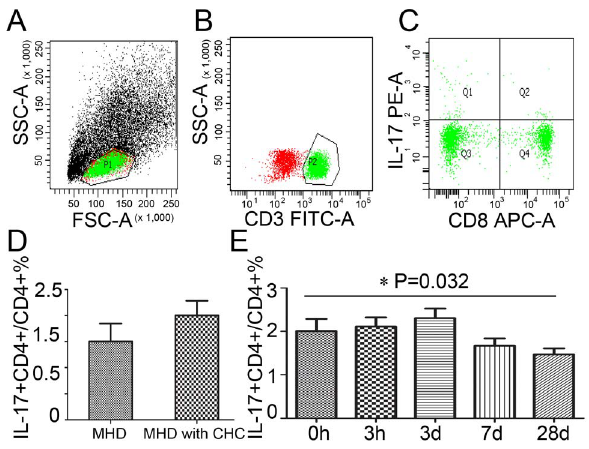
Figure 5. The changes of Th17 cells in PBMC after the DFPP. A- C. Th17 cell was expressed as CD17 + CD4 + cells in PBMC. D. The frequency of Th17 cells in MHD patients with CHC compared to those without CHC. E. The frequencies of Th17 cells in MHD patients with CHC during the DFPP.